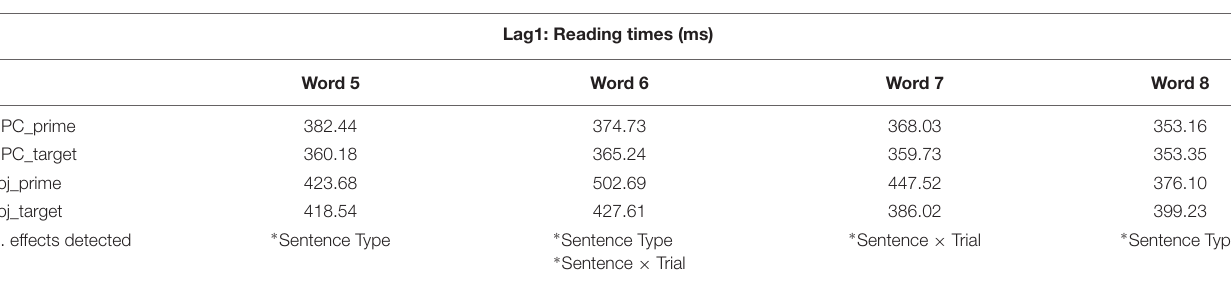
FIGURE 4 | Mean reading times (ms) for CNPC and Subject islands in Lag1. Error bars represent ± 1 standard error. TABLE 3 | Lag1 mean reading times for words in the region of